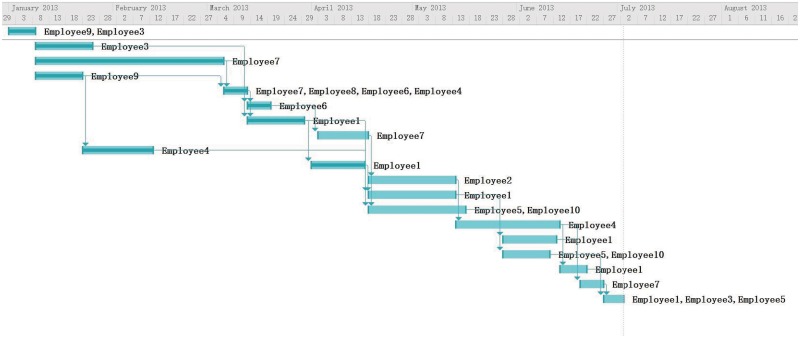
Rescheduling Result from Expert 1.